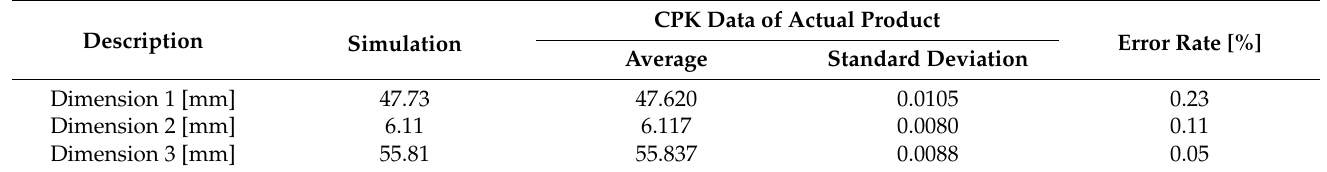
( b ) Figure 18. Mold of the open lever applying 0.5% shrinkage-rate constant. ( a ) Lower part. ( b ) Upper part.